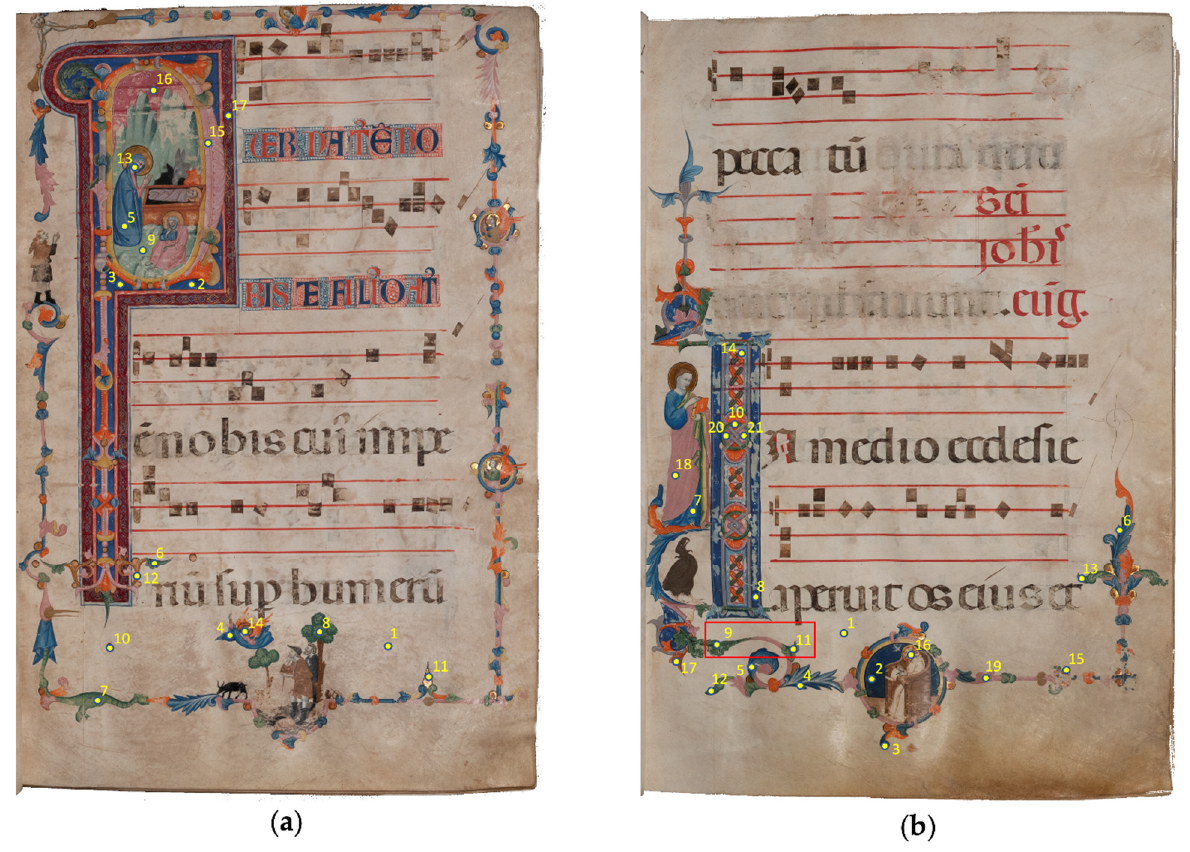
Figure 1. By permission of the Library of S. Bernardo alle Terme (Roma). Points of XRF and FORS analyses of ff. ( a ) 8r and ( b ) 18r. The red rectangle shows the break between the artist close to the workshop of Pacino di Bonaguida (point 9) and the Maestro Daddesco (point 11). The complete XRF analysis is provided in Table S1 of Supplementary Materials.